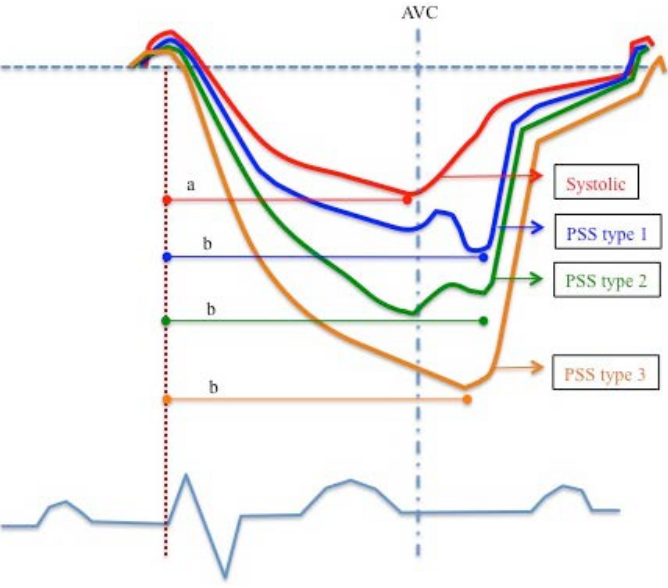
Figure 1. Morphological types of longitudinal deformation observed in healthy subjects. a: Duration of systolic deformation; b: Duration of postsystolic deformation. AVC: Aortic valve closure. PSS: Postsystolic shortening. (Referred only to the morphology, regardless of its amplitude).